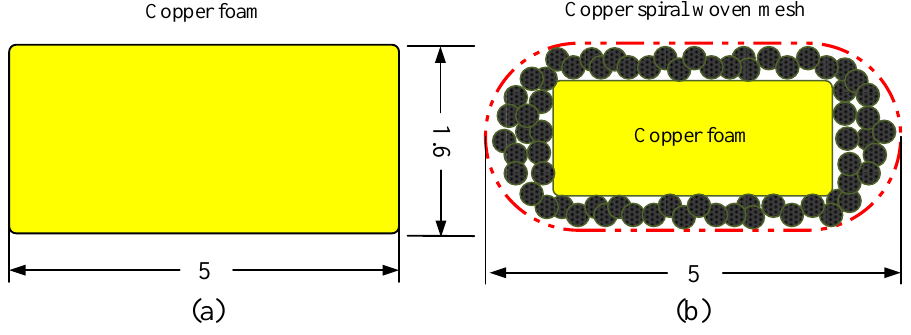
Figure 4. Schematic diagram of the cross-section of the wick in different configurations in mm. ( a ) Copper foam wick; ( b ) Copper spiral woven mesh and copper foam composite